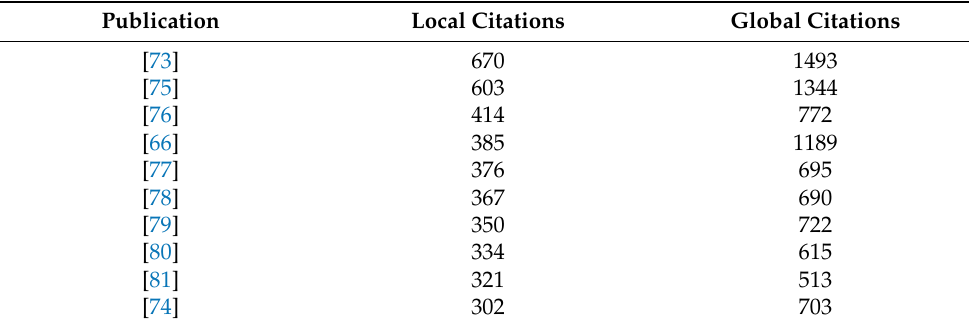
Table 7. Top ten most cited articles with local and global